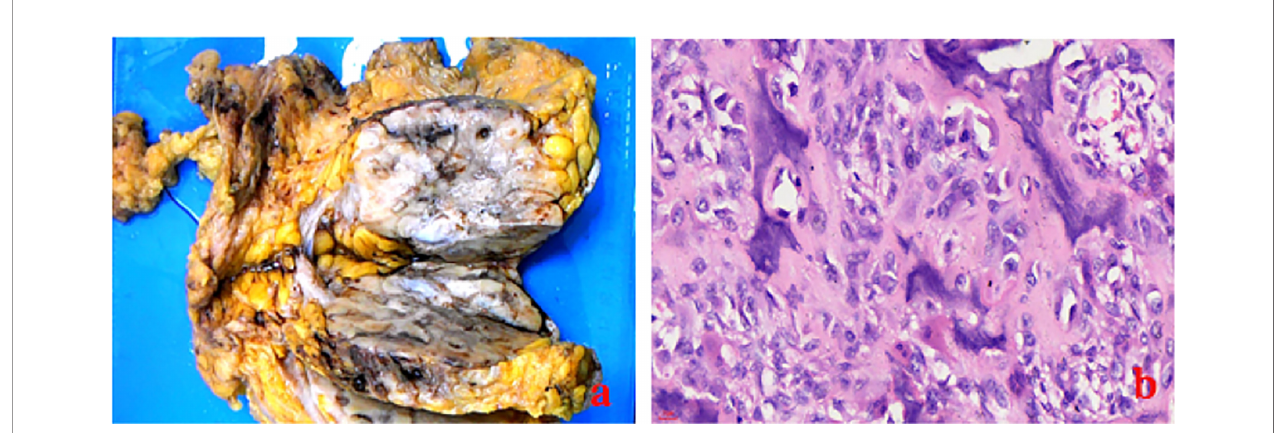
FIGURE 3 | The gross specimen (A) and the histologic result ( B :ross specimen (A) showed a 7 cm × 8 cm × 8 cm mass in the central region with clear boundary, regular shape, and pectoralis major invaded, and the histologic result ( B : HE×40) showed that it was rich in osteoid tissues, heteromorphic osteoblast-like cells, and multinucleated giant